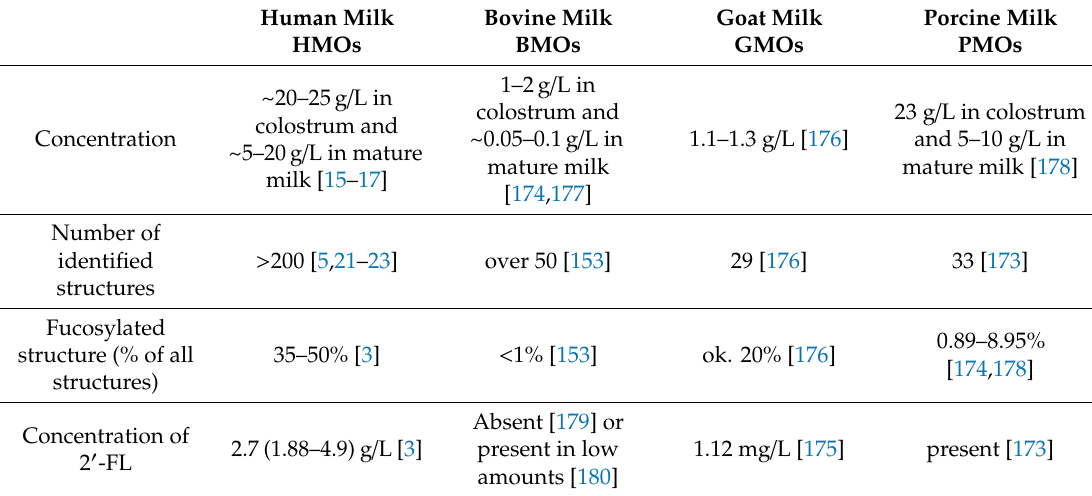
Table 2. Characteristics of milk oligosaccharides of some